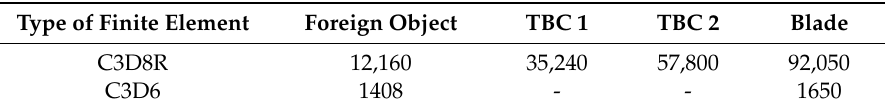
Figure 6. Finite element mesh. TBC: thermal barrier coating. Table 2. Number of finite elements.